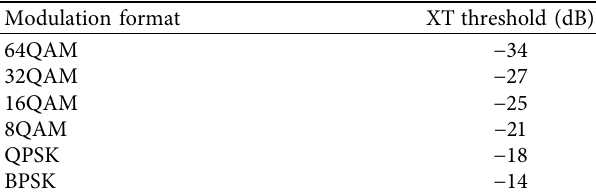
Table 2: XT threshold for each modulation format